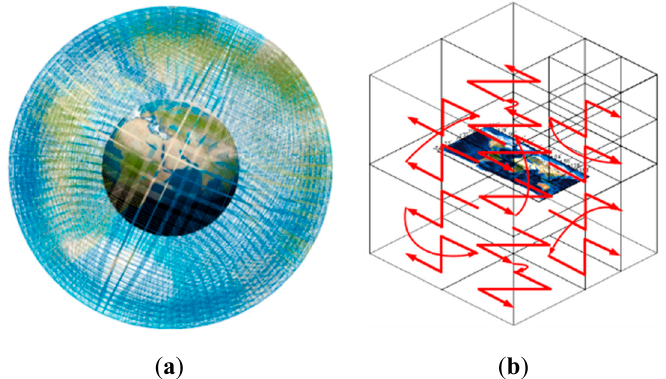
Figure 2. GeoSOT-3D model: ( a ) Global grid model; ( b ) Z-order filling curve.